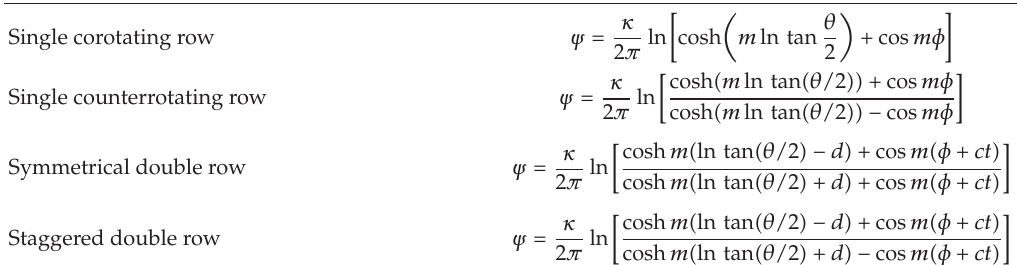
Table 2: Some vortex streets on the sphere; m (cid:7) 1 , 2 , 3 ,...